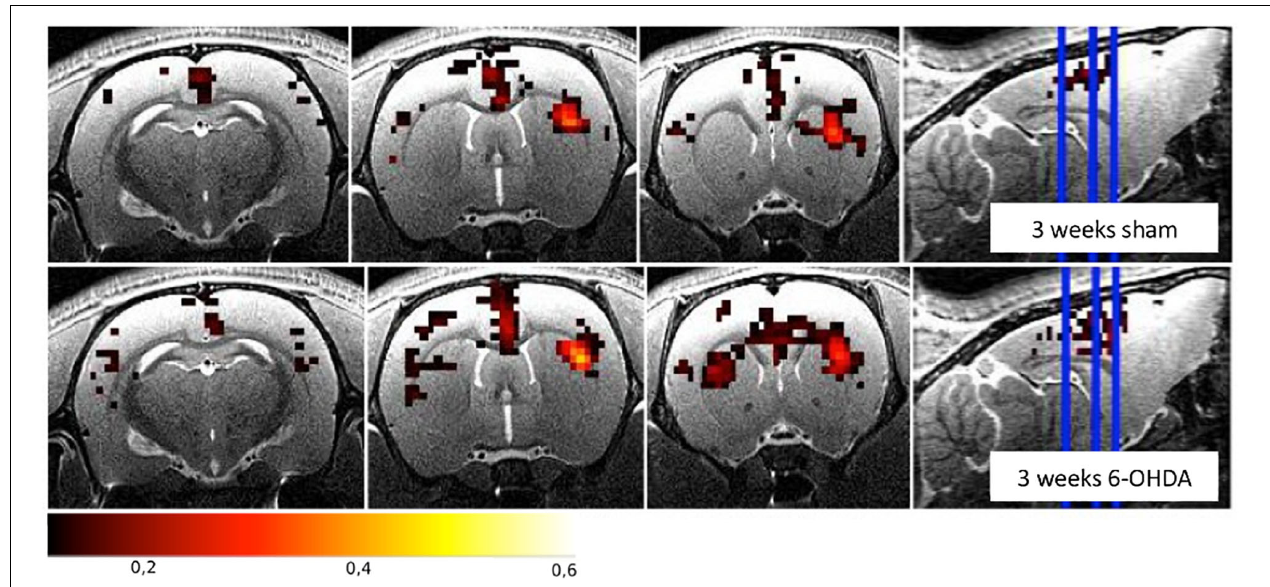
FIGURE 3 | Functional connectivity maps from the right striatum for the sham-operated and the 6-OHDA groups at 3 weeks postinjection in the right hemisphere (i.e., on the right side of the brain on the images). The 6-OHDA group shows a non-significant increase of FC between the left and right striatum. Maps are expressed as correlation coefficient R . See Perlbarg et al. (2018) for the full study